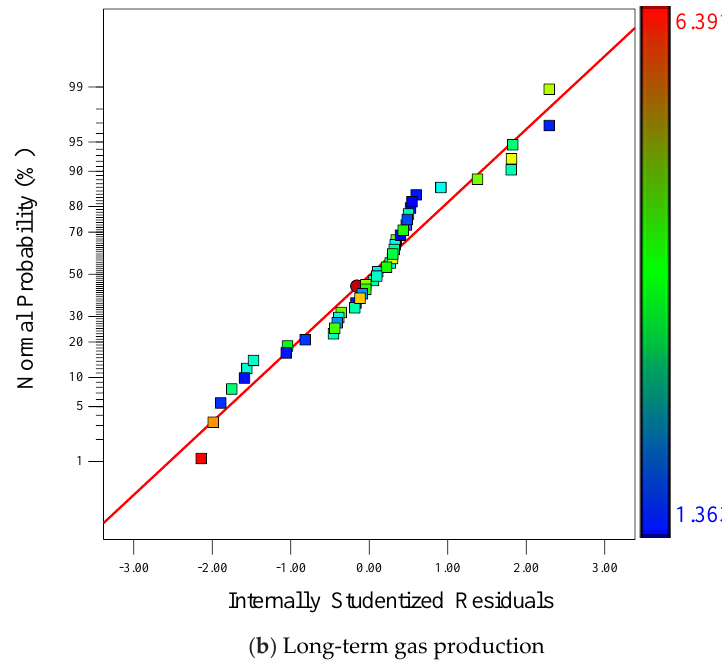
Figure 8. Normal plot of residuals at different production period.